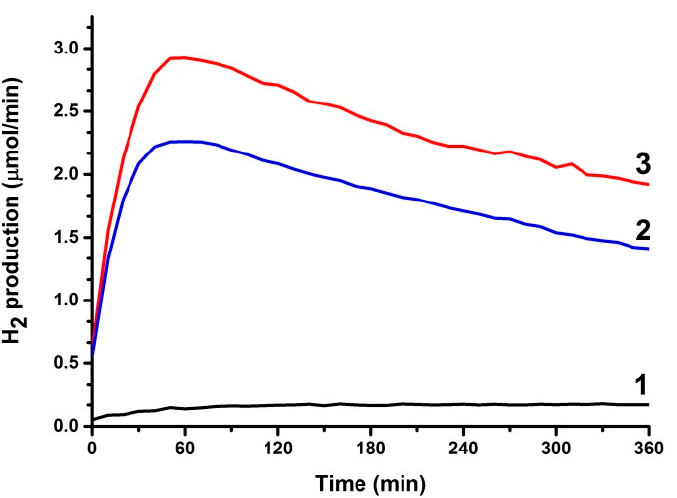
Figure 6. Hydrogen production rate using the “photoelectrocatalytic leaf” (short-circuited electrodes) of Figure 2B,C. The photoanode was made of np-TiO 2 while the electrocatalyst was made of: (1) 4 mg of Elcocarb alone; (2) 0.6 mg Pt alone and (3) 0.08 mg of Pt dispersed in 4 mg of Elcocarb. The alkaline electrolyte contained 5 v %